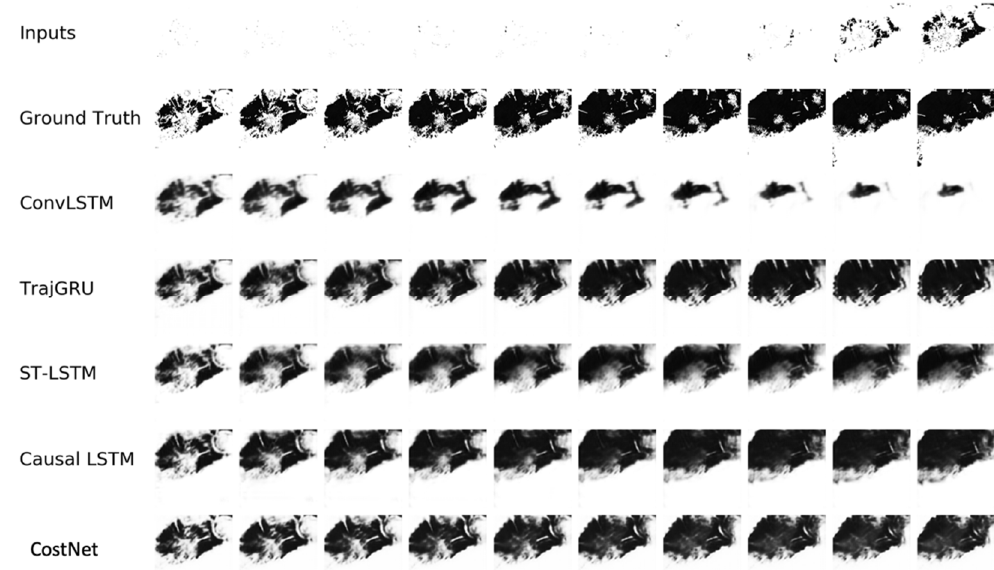
Figure 6. Prediction examples on the radar test